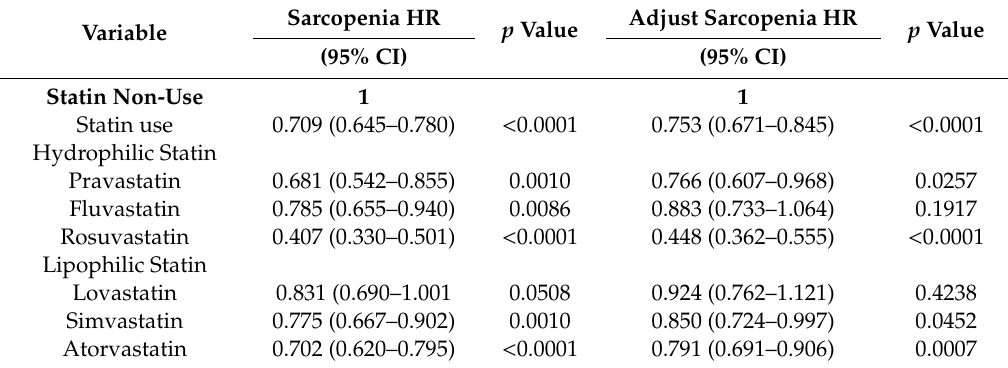
Table 8. Association between six types of statins and first-time sarcopenia among CKD patients in Taiwan.